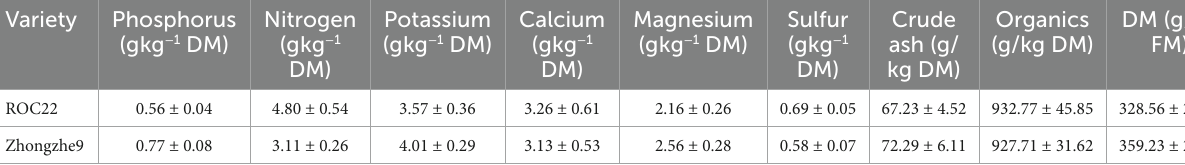
TABLE 1 The composition of leaves of different cultivar. Variety